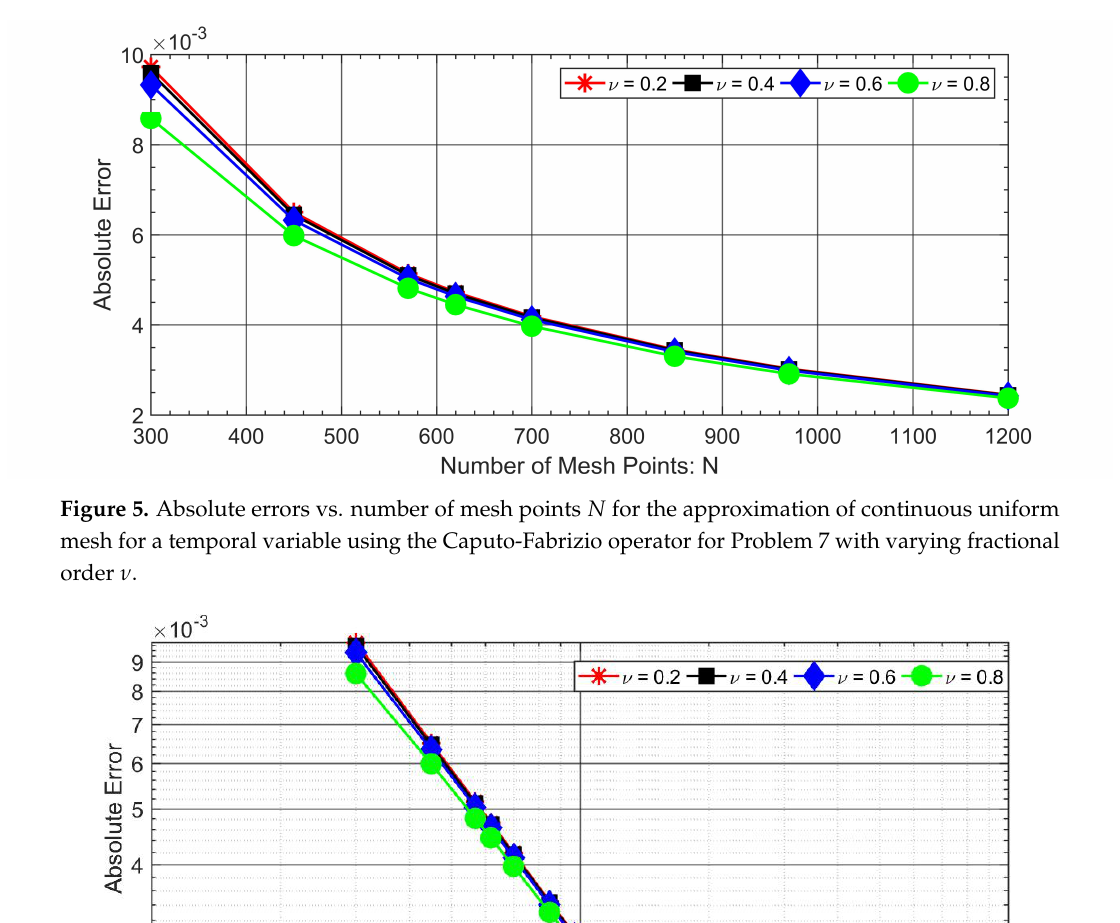
Figure 4. Absolute errors vs. number of mesh points N for the approximation of continuous uniform mesh for a temporal variable using the Caputo-Fabrizio operator for Problem 7 with varying fractional order ν .